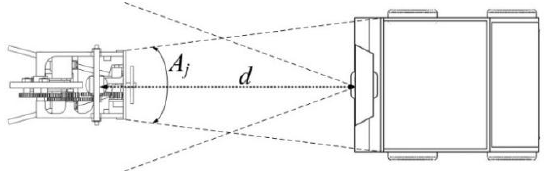
Figure 8. Diagram showing the relative distance